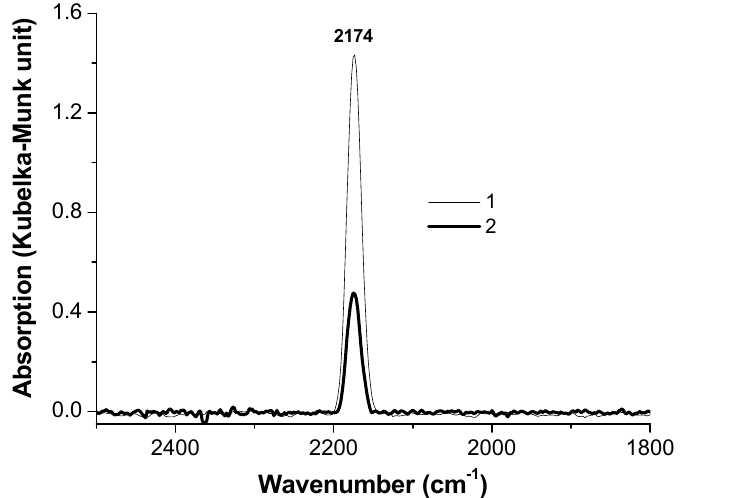
Figure 4. DRIFT-CO spectra of the CuO-ZnO-SiO 2 ( 1 ) and CuO-ZnO-SiO 2 -WC ( 2 ) catalysts after reaction at 200 ◦ C.